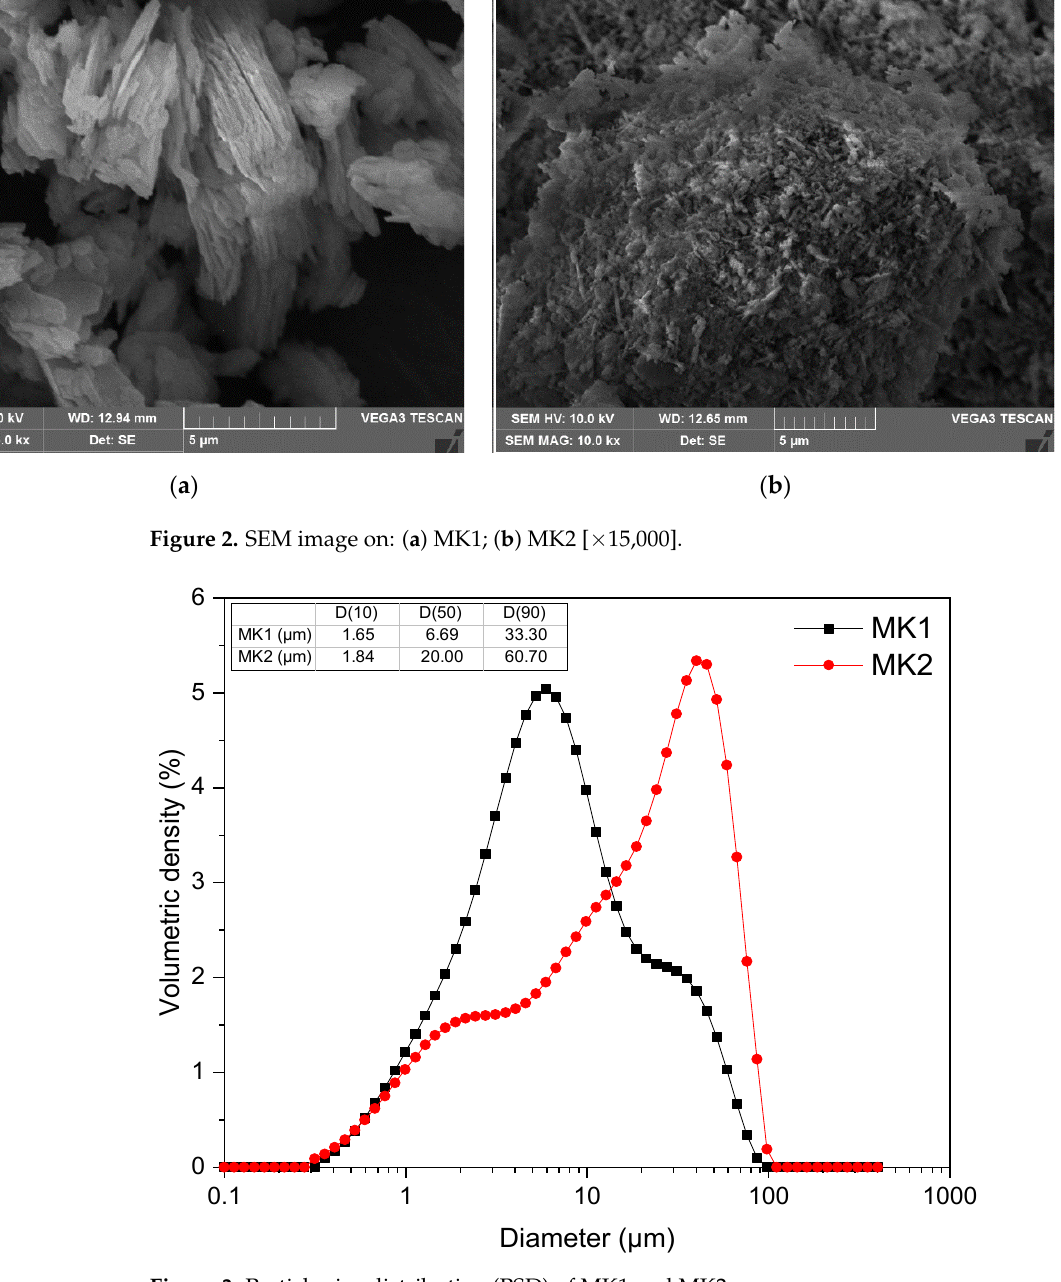
Figure 3. Particle size distribution (PSD) of MK1 and MK2.